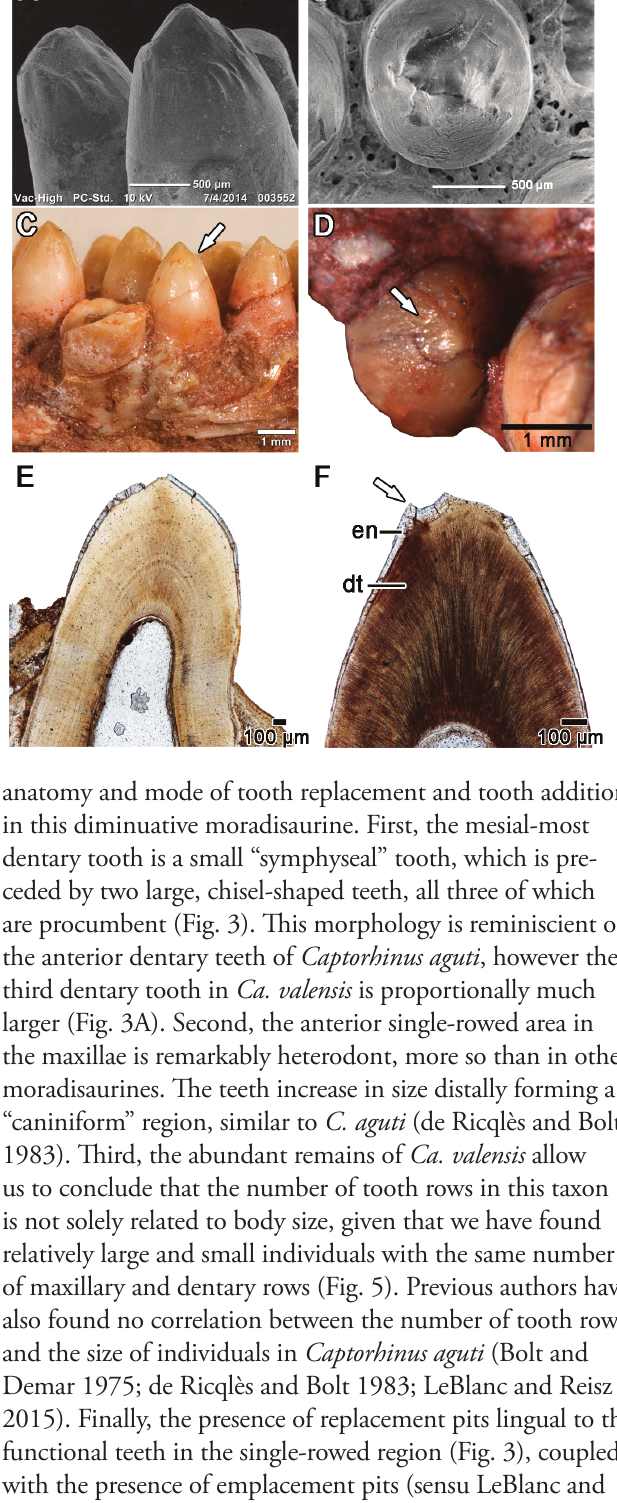
Figure 4. Comparisons of tooth crown morphology of Captorhinikos valensis specimens from Bally Mountain and the holotype dentary from the Vale Formation of Texas (FMNH UR 101). A, SEM of tooth crowns in lingual view in multiple-rowed area of a partial dentary (OMNH 77535) showing the ring of enamel encircling the tooth crown; B, SEM of same region of a dentary in occlusal view; C, closeup image of the tooth crowns in the multiple-rowed region in the Ca. valensis holotype (FMNH UR 101) showing identical crown morphology to those in A and B from Bally Mountain. D, closeup image of the occlusal surface of a posterior